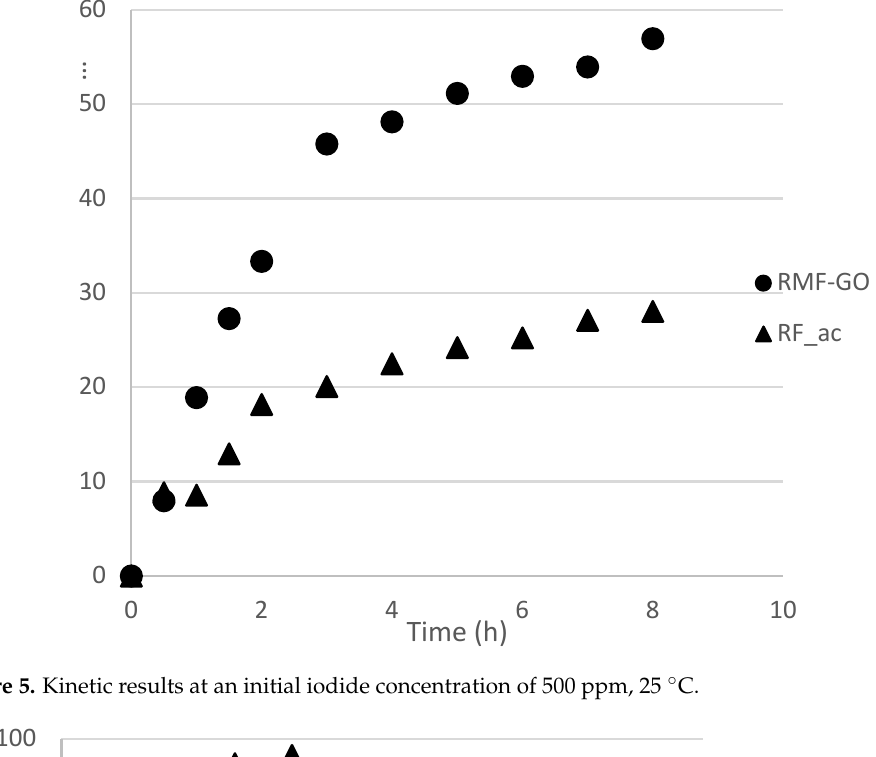
Figure 5. Kinetic results at an initial iodide concentration of 500 ppm, 25 °C.